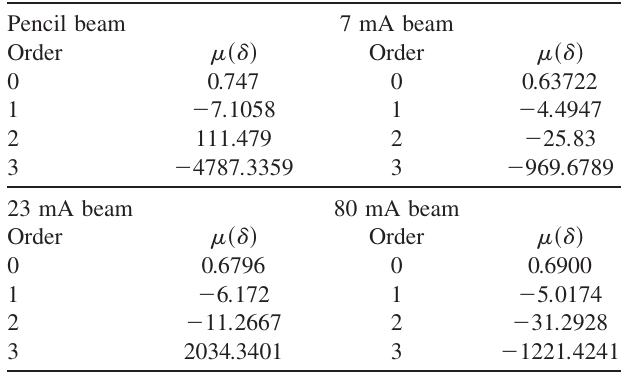
TABLE I. Betatron tune predictions for four operating points. The first column contains the order of the term: 0th order is the , 2nd is ð d 2 (cid:3) Þ = ð d(cid:2) 2 Þ etc. The second column tune itself, 1st is d(cid:3) d(cid:2) is the value predicted by COSY . The four operating points are labeled above the